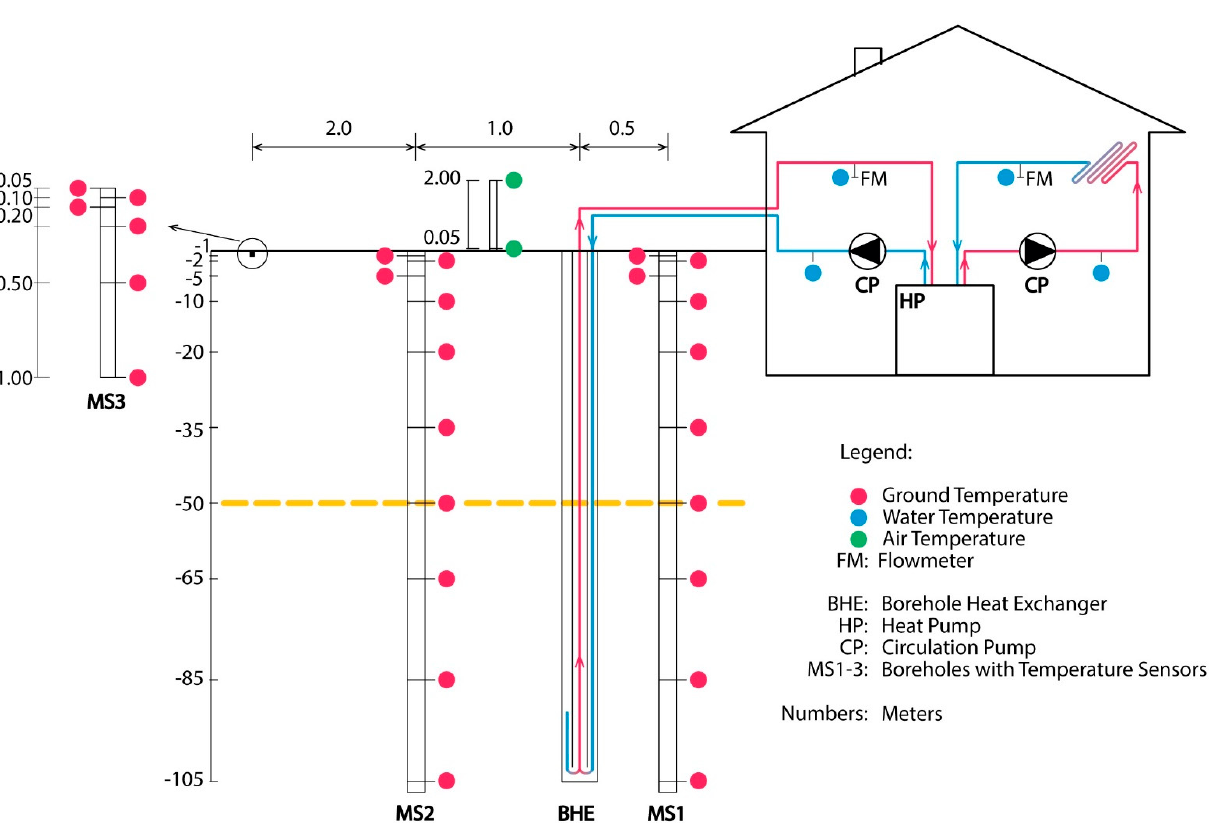
Figure 3. Measurement instrumentation setup at the GHP test facility at Elgg, with its 38 sensors. Outside: The two 105 m deep boreholes MS1 and MS2, each with ten temperature sensors (GT); the 1–m deep borehole MS3 with five sensors; the meteo-station with air-temperature sensors (AT). Inside: Basement: flowrate-meters (FM), flow-temperature meters (WT). Inside rooms: Various temperature sensors. Blue line left above HP and into BHE: heat carrier flow into BHE, red line: heat carrier flow from BHE into HP. Red line right above HP: heated fluid flow into space heating system, blue line: return flow. Dashed yellow line at 50 m depth marks the horizontal plane in which the model calculations in section 2.2. were done. Data from [4] are plotted.